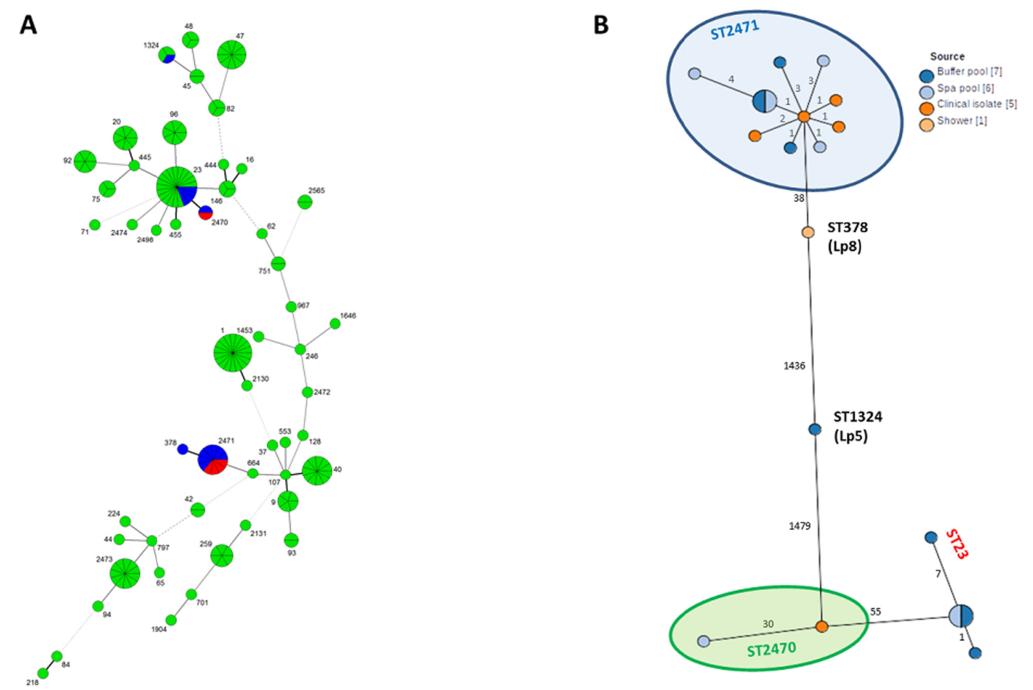
Figure 2. ( A ) Minimum spanning tree of 170 Legionella pneumophila Sequence Type isolated in 2017 based SBT allelic profiles (7 genes). Blue charts represent environmental isolates from the aquatic centre; red charts represent the isolates from the patients; green charts represent the other French isolates typed in 2017. Numbers beside each circle represent the sequence type (ST). ( B ) Minimum spanning tree of 19 Legionella pneumophila isolates from the epidemiological investigations based on cgMLST allelic profiles (1973 genes) extracted from whole genome assemblies using chewBBACA software.